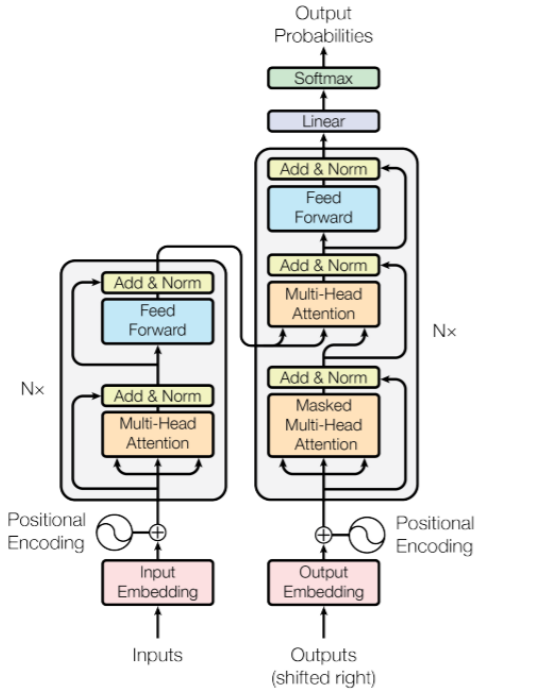
Figure 1. Transformer model proposed in